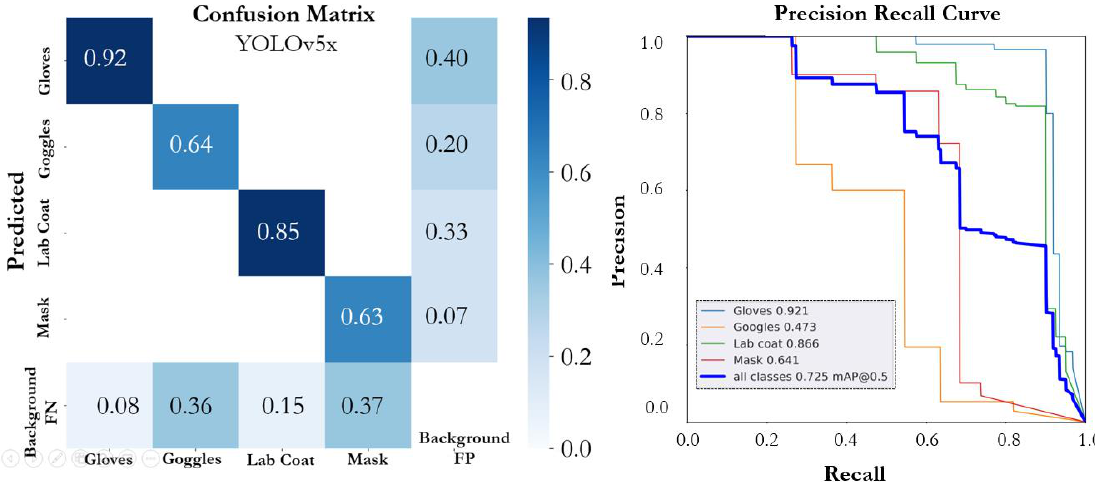
Figure 11. Confusion matrix and PR curve of the YOLOv5l model.